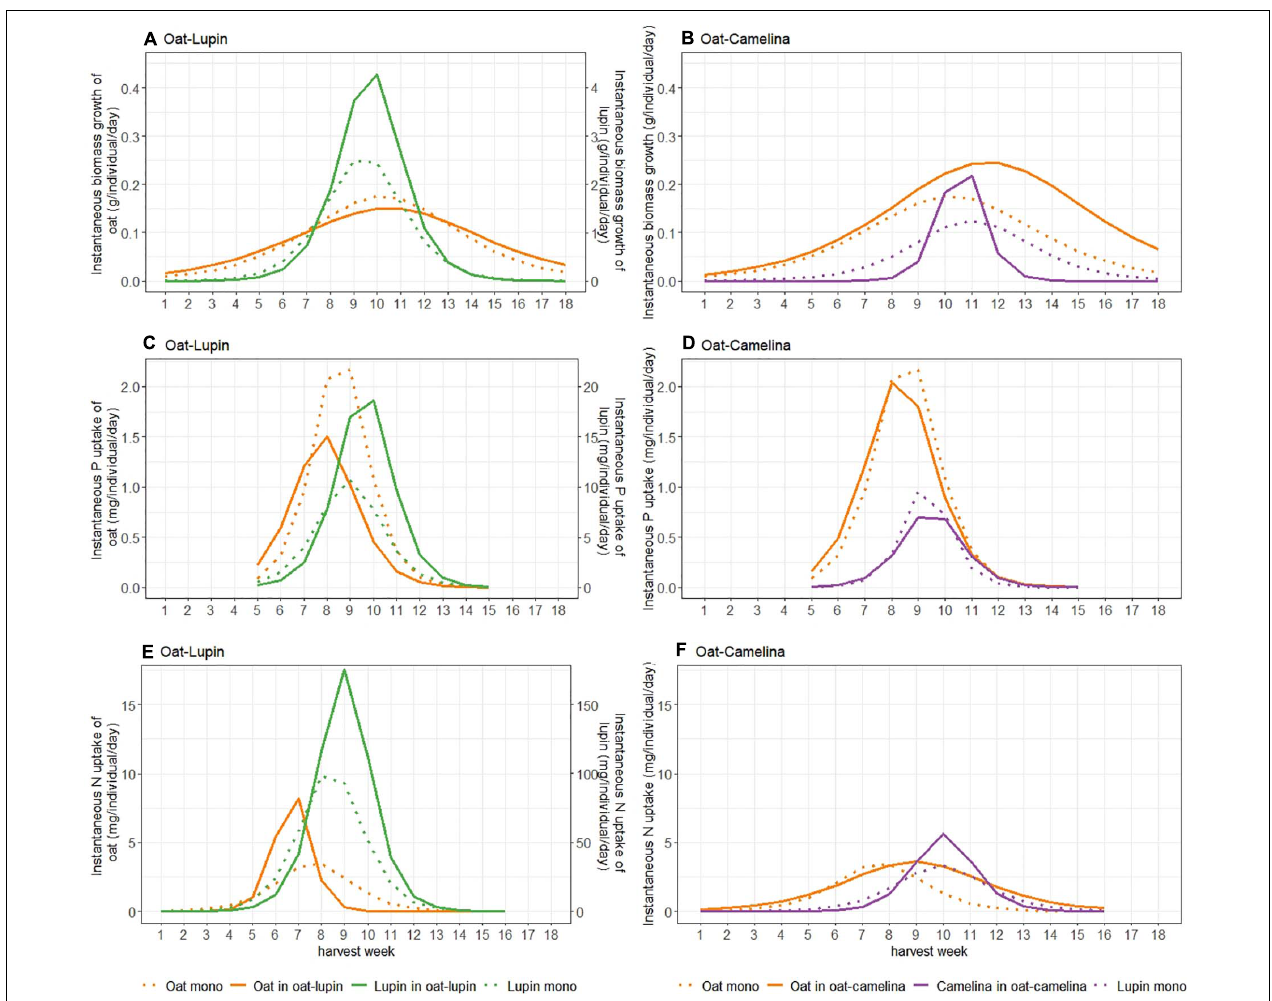
FIGURE 2 | Instantaneous biomass accumulation (A,B) , P (C,D) and N (E,F) uptake of either species in the oat–lupin (A,C,E) and oat–camelina (B,D,F) mixtures (solid lines) and monocultures (dotted lines). Instantaneous biomass growth and N uptake of lupin (A,E) are given on a second x -axis and are a factor 10 higher compared to values of